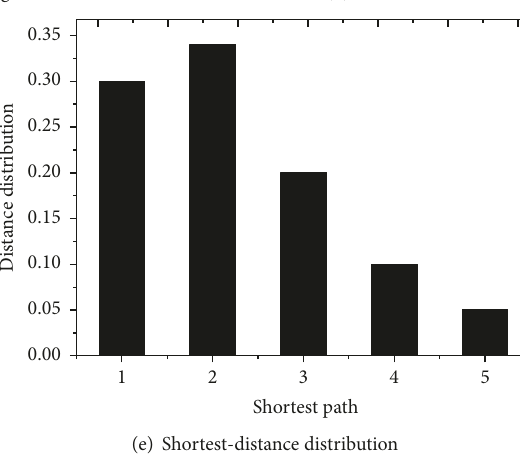
Figure 3: Characteristics of the Beijing urban rail transit passenger flow